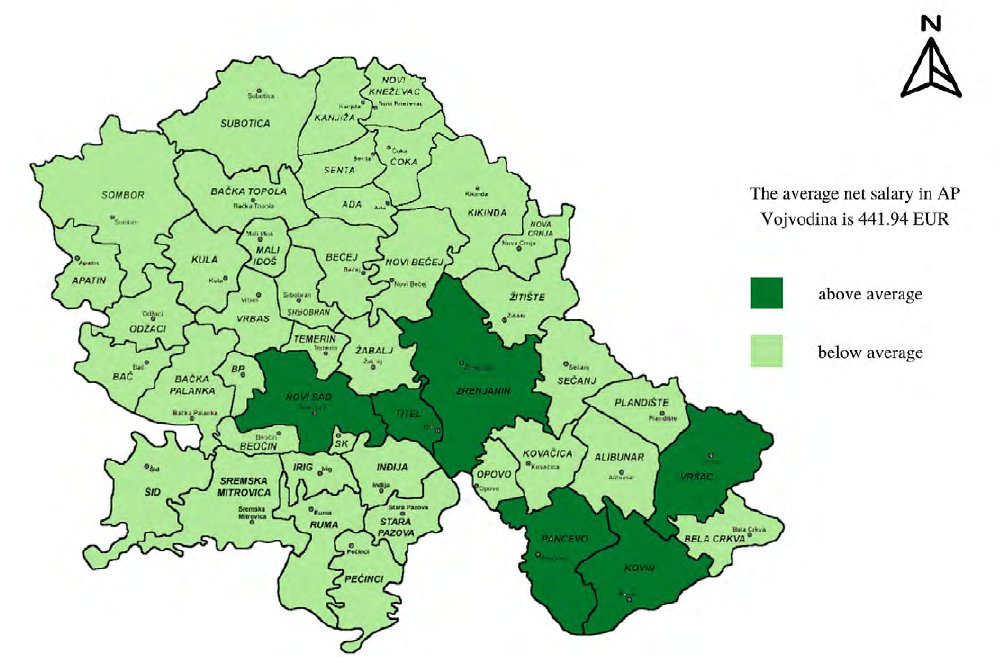
Figure 2. Average net salary in local self-governments in